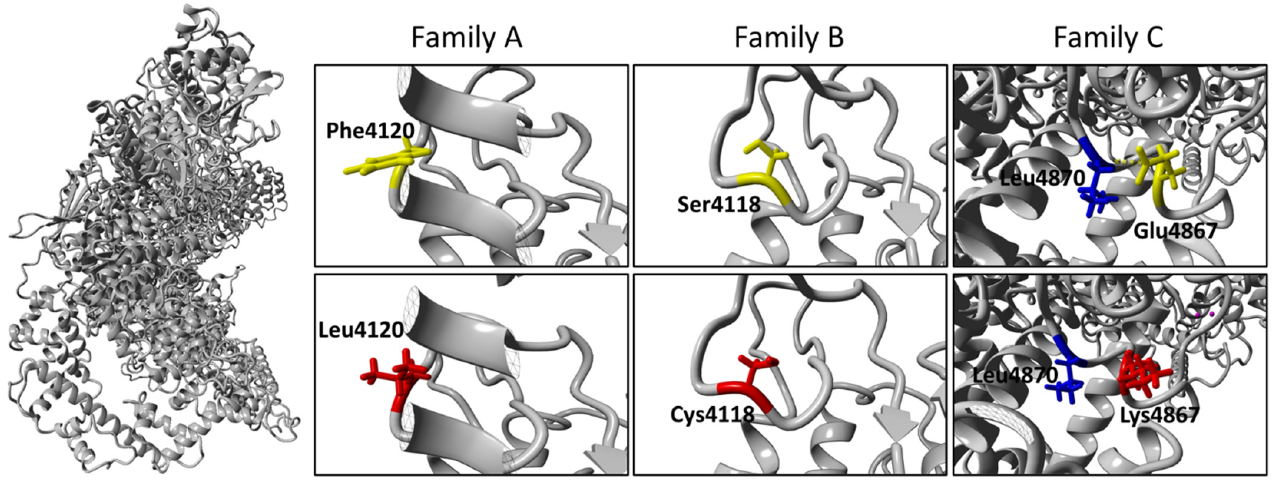
Figure 7. 3D homology modeling. 3D homology modeling of human RNF213 protein (NP_001243000) based on the cryo-EM structure of mouse RNF213 (RCSB-PDB: 6TAX) for wild-type and mutant forms. Magnification of residues affected by substitution are shown for each family, with the side chain of wild-type residue (yellow) on the upper panel, and the side chain of mutated residue (red) on the lower panel. The hydrogen bond is lost between the side chain of Leu 4870 (blue) and Glu 4867 .